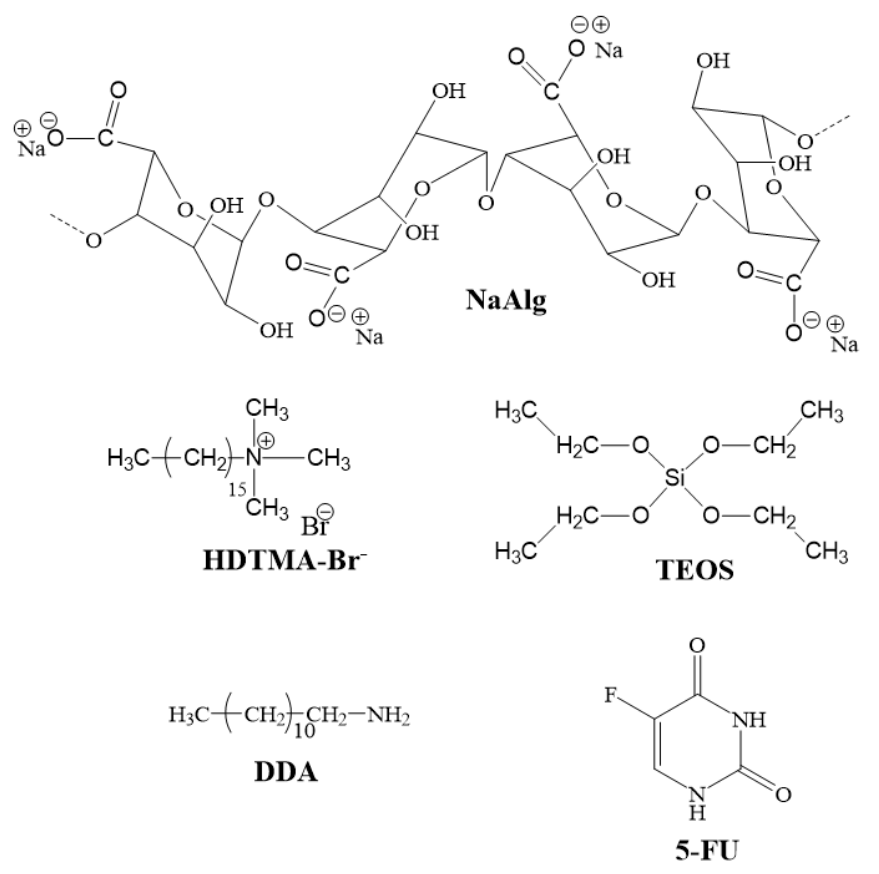
Figure 1. Chemical structure of raw materials.